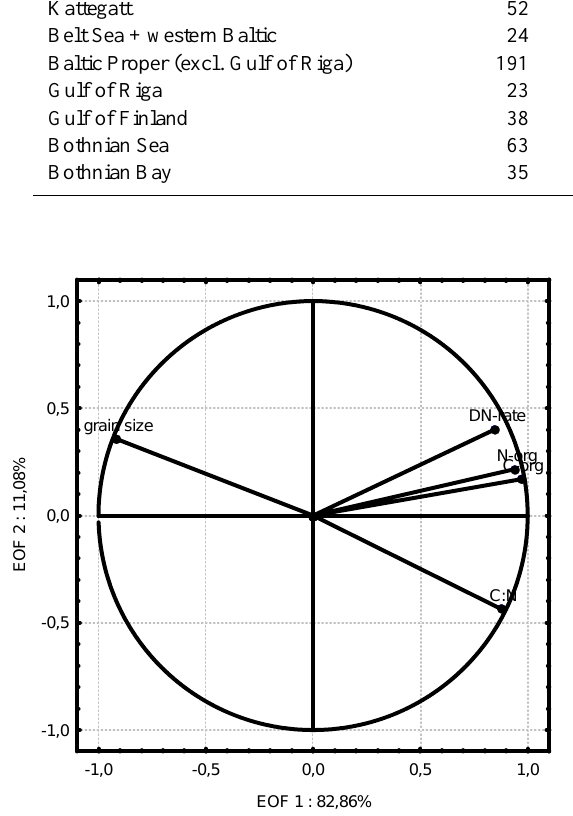
Figure 4: Projection of the fitting coefficients in EOF coordinates. Fig. 4. Projection of the fitting coefficients in EOF